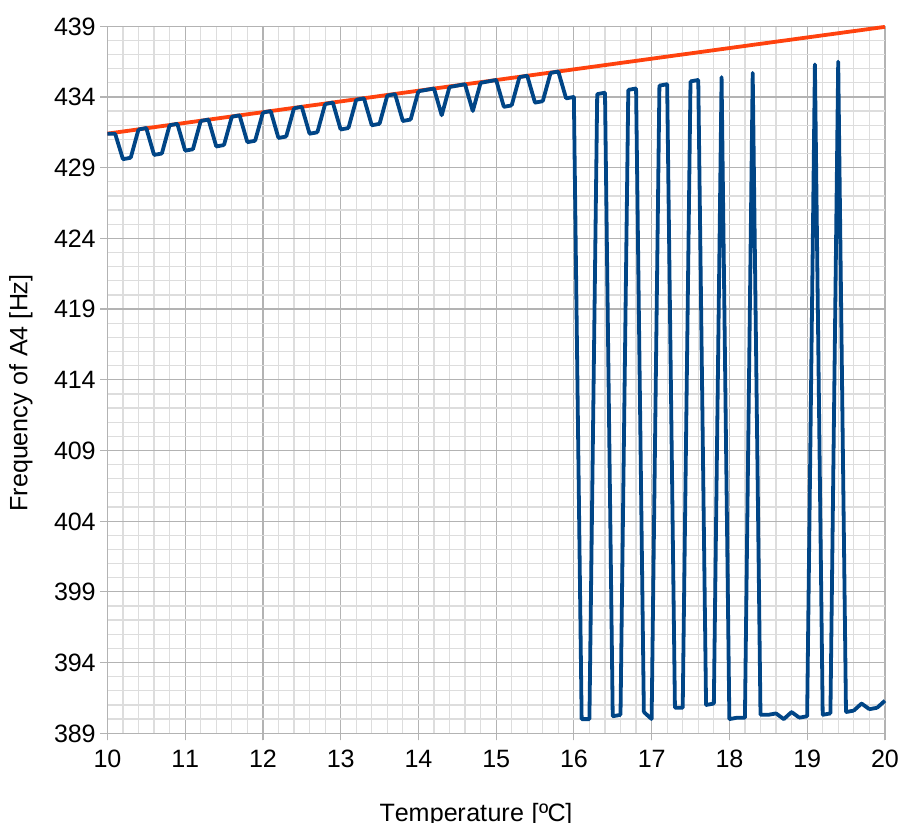
Figure 5. The relationship between the sound A4 frequency (Pietro Aaron’s temperament) and temperature. The change in frequency of pipe A4 of λ = 0.39073 m (435.8 Hz for T = 15.8 ◦ C) is marked in